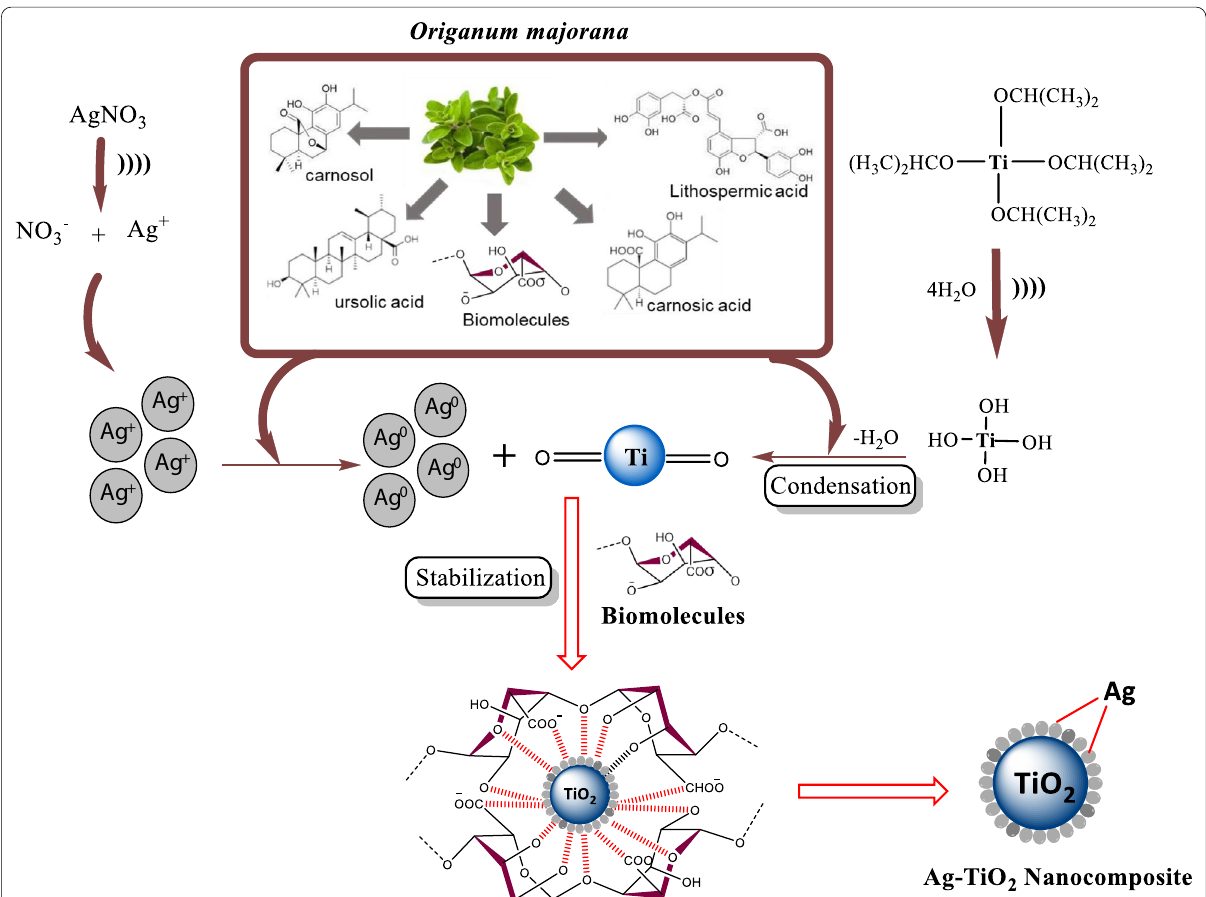
Fig. 5 Plausible mechanism for the formation of Ag–TiO 2 NCs using Origanum majorana leaf